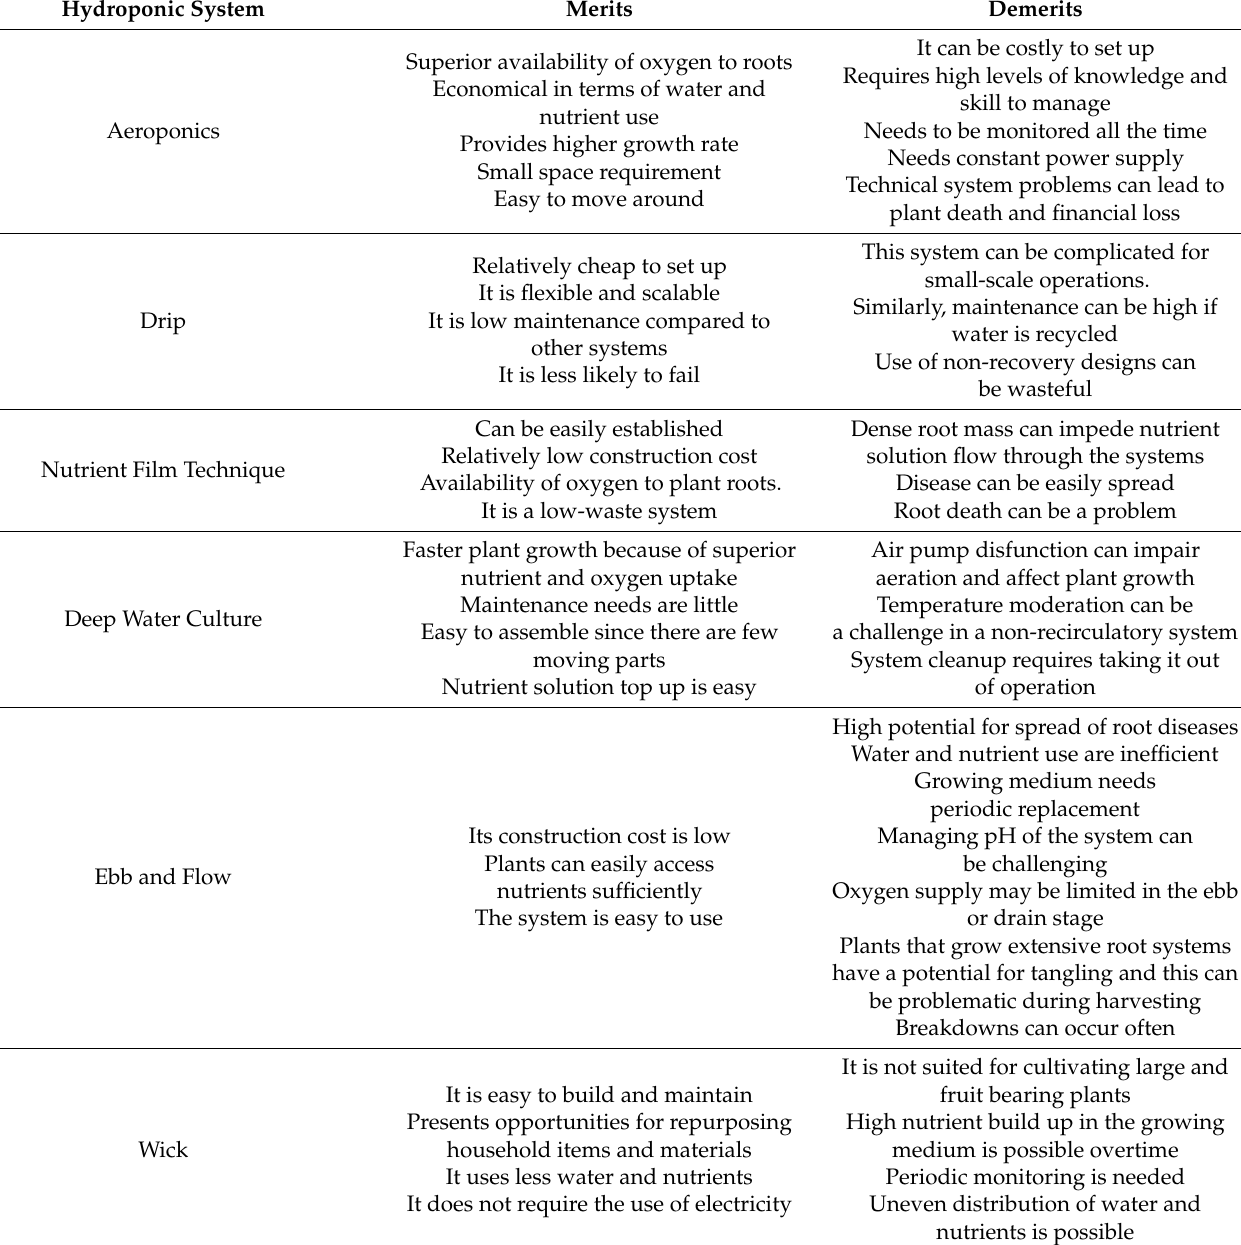
Table 5. Merits and demerits of the various hydroponic